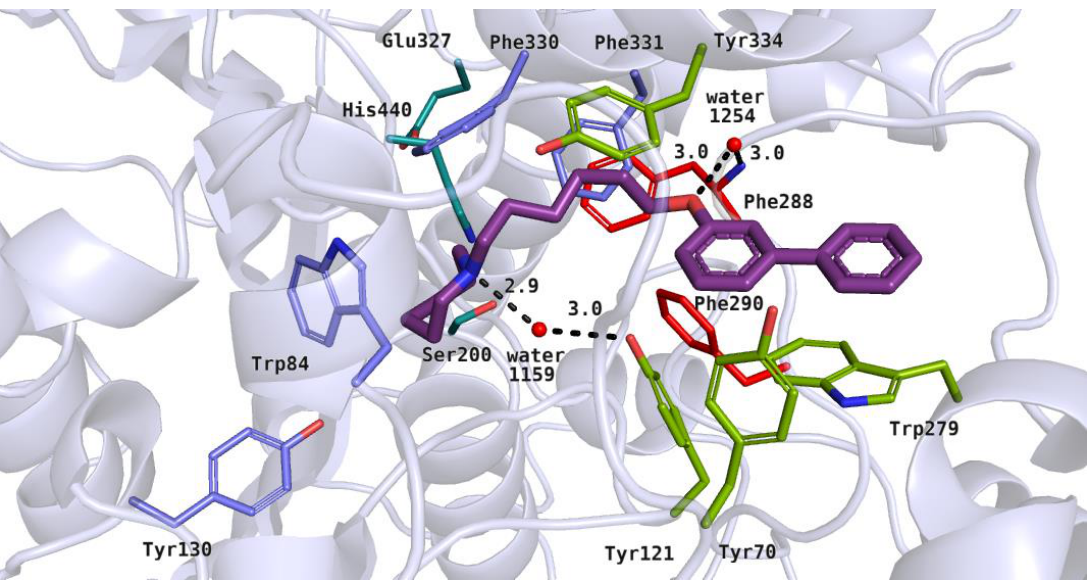
Figure 8. Binding mode of compound 21 within the acetylcholinesterase active site. Residues colored in teal mean catalytic triad, blue — anionic site, green — peripheral anionic site, red — acyl pocket.